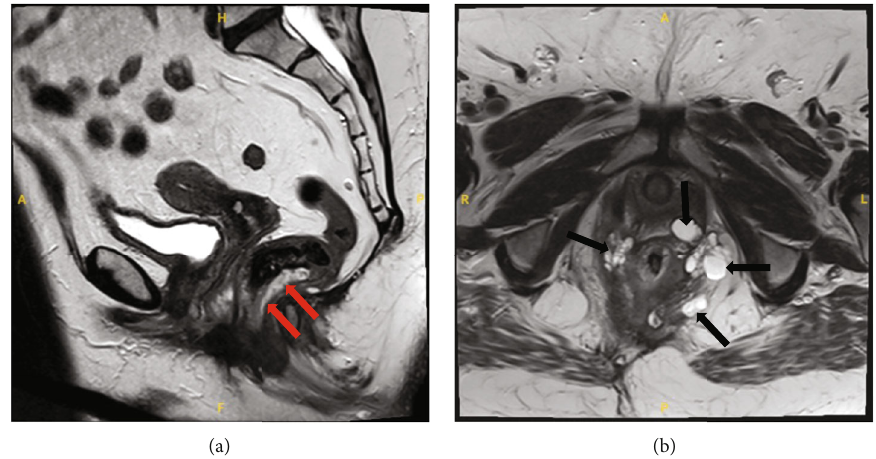
Figure 4: Pelvic MRI 13 months later with a sagittal T2 weighted image (a) and an axial T2 weighted image (b) demonstrated a T2 hyperintense mass within the posterior wall of the low rectum (red arrow) and multiple additional T2 hyperintense perirectal masses (black